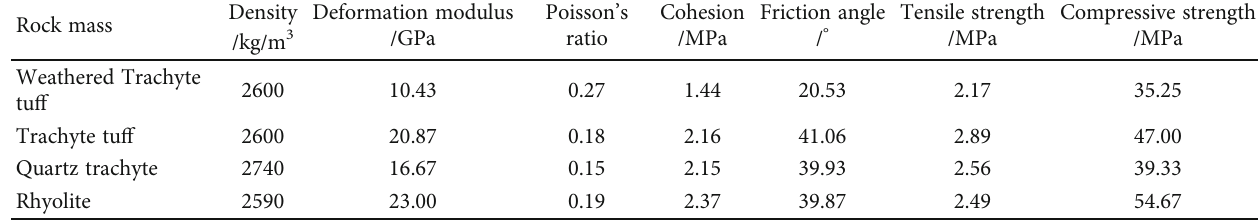
Table 1: Mechanical parameters of Jiguanshan molybdenum ore rock body.